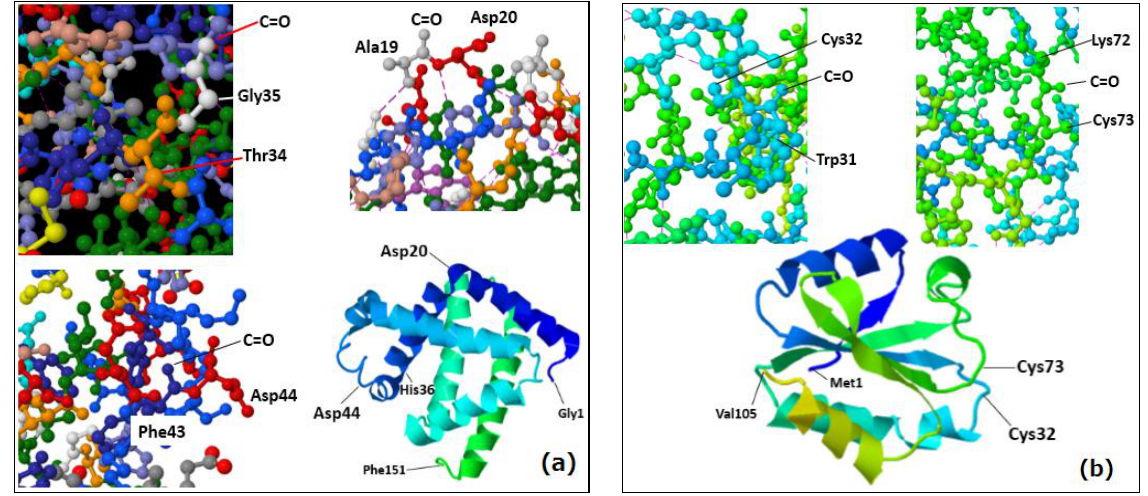
Figure 4. The sites of carbonyl groups at ( a ) Xxx-Asp20, Xxx-Asp44 and Gly35-Xxx residues obtained from the X-ray crystallography structure of myoglobin (PDB: 2FRF); ( b ) Xxx-Cys32 and Xxx-Cys73 residues of thioredoxin (PDB: